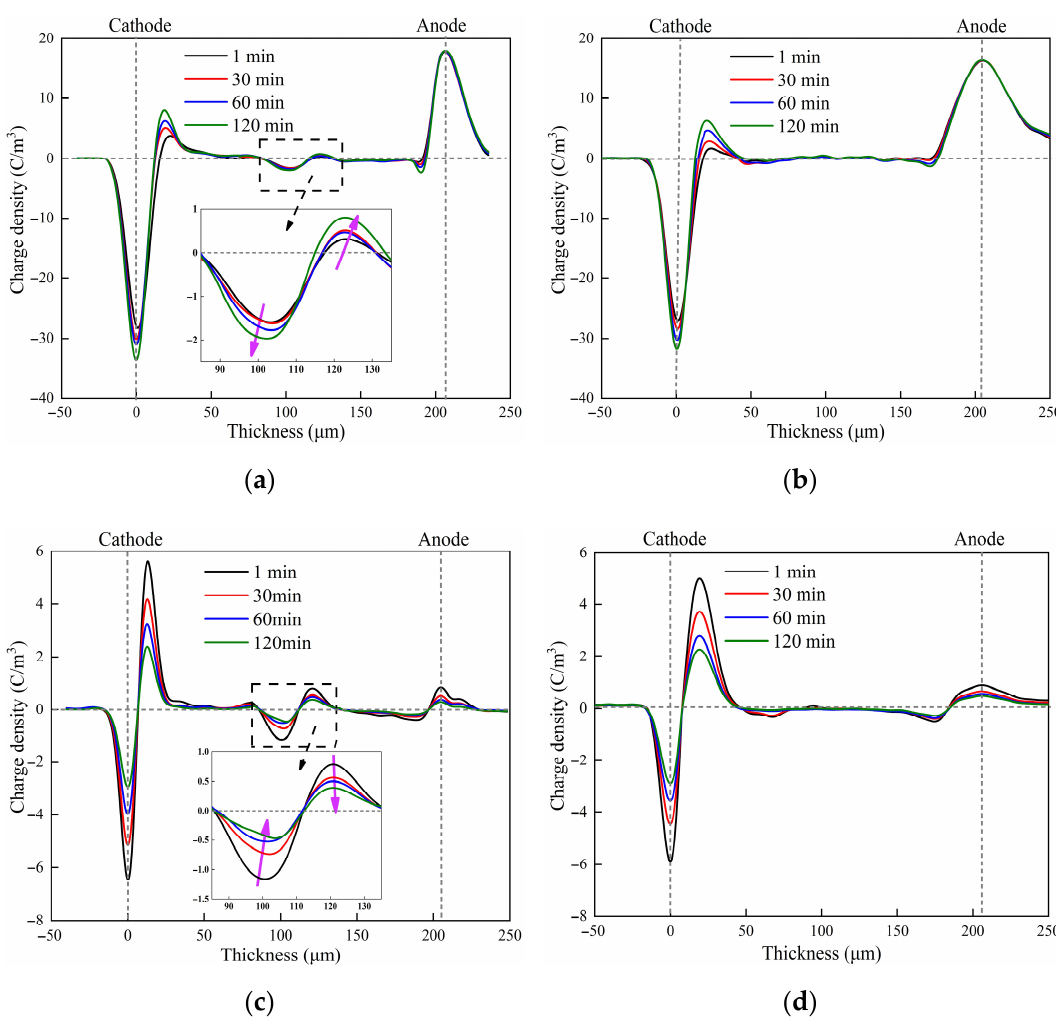
Figure 2. The charge distribution: ( a ) polarization in H-XLPE bilayer; ( b ) polarization in XLPE; ( c ) depolarization in H-XLPE bilayer; ( d ) depolarization in XLPE.